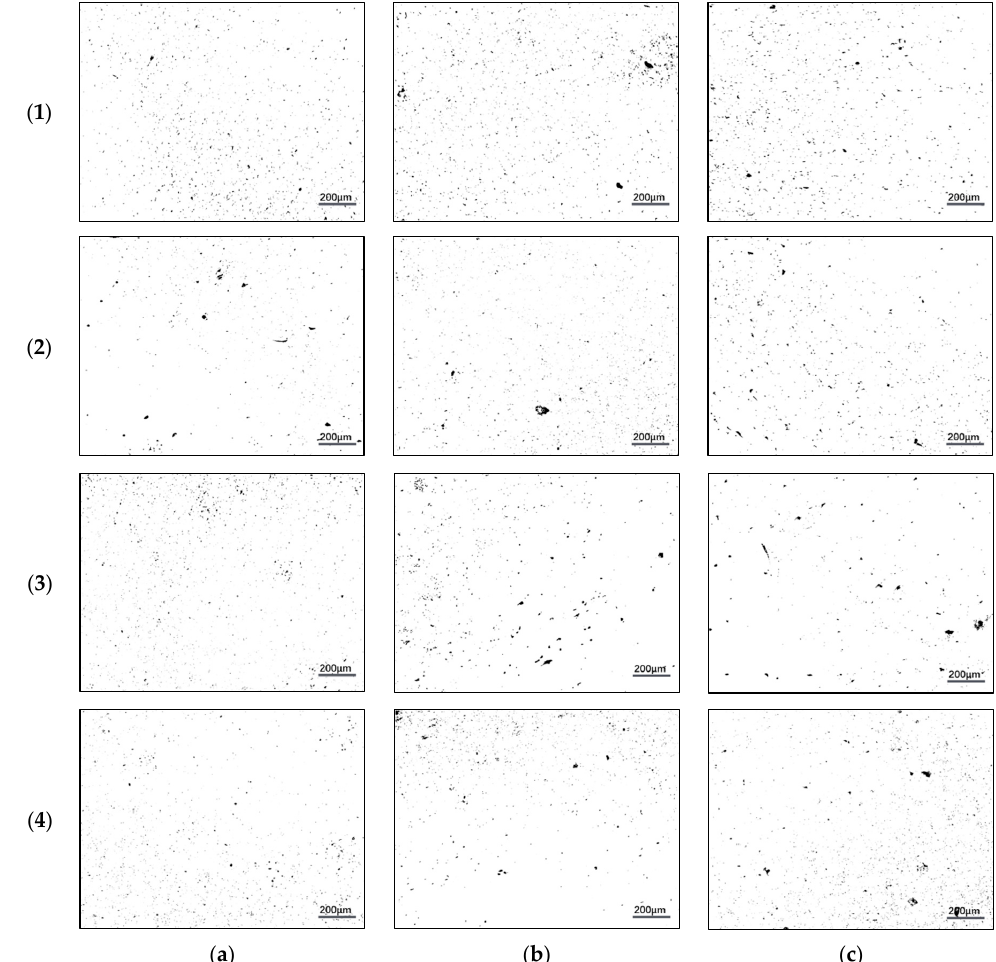
Figure 4. Optical micrographs of sintered Cu–15Fe powder compacts: ( 1 ) blank sample, ( 2 ) PW sample, ( 3 ) SA sample, and ( 4 ) PW+SA sample under different pressures: ( a ) 50 MPa, ( b ) 200 MPa, and ( c ) 350 MPa. Table 2. Percentage of area porosity of sintered Cu–15Fe powder compacts with varying lubricant types under different pressures.